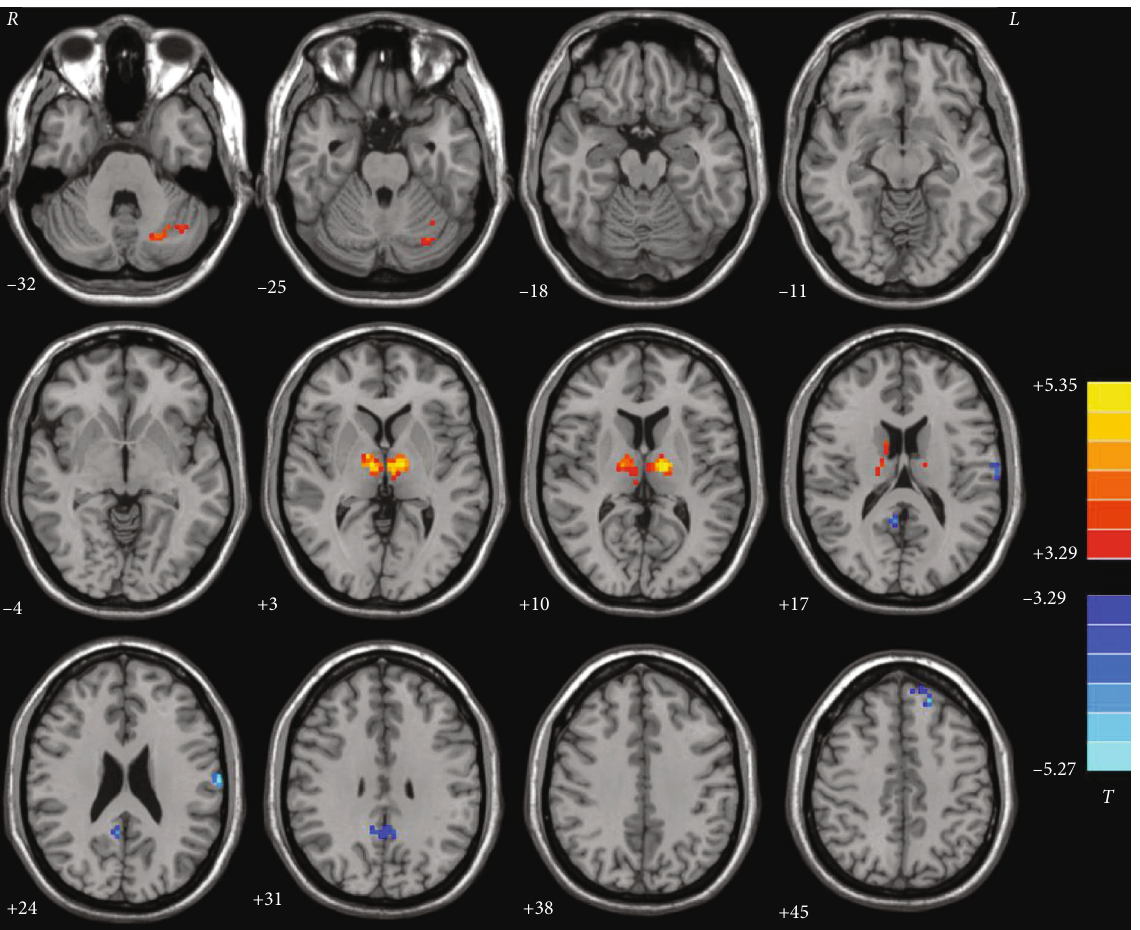
Figure 1: Brain regions with abnormal degree values in patients with OCD. t values from two-sample t tests with p < 0 : 05 (GRF corrected). Red denotes increased degree values; blue denotes decreased degree values. OCD =obsessive-compulsive disorder; GRF =Gaussian random fi eld; L =left; R =right.